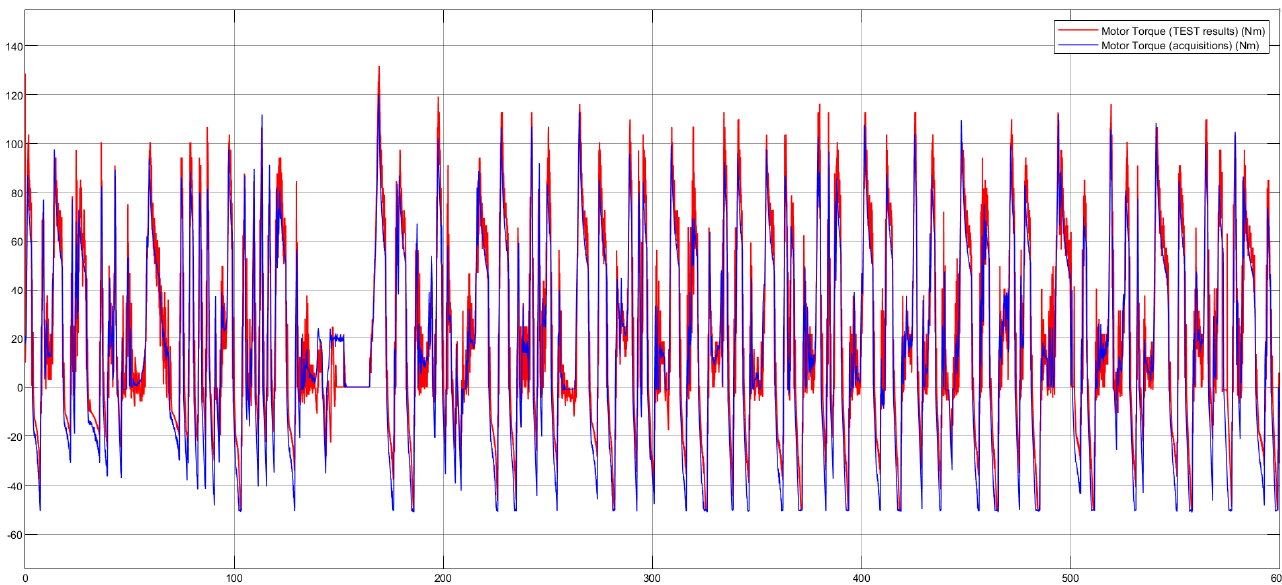
Figure 8. Motor torque (in Nm) vs. lap time expressed in seconds. In particular, in the figure, there are the motor torque resulting from the model (in red) and the motor torque acquired through the Vehicle Control Unit (VCU) of the waste collection vehicle prototype (in blue).